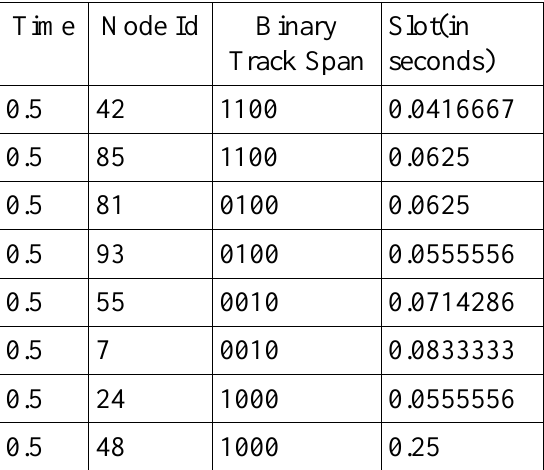
Table 1.a Slot Allocation table at the various time period